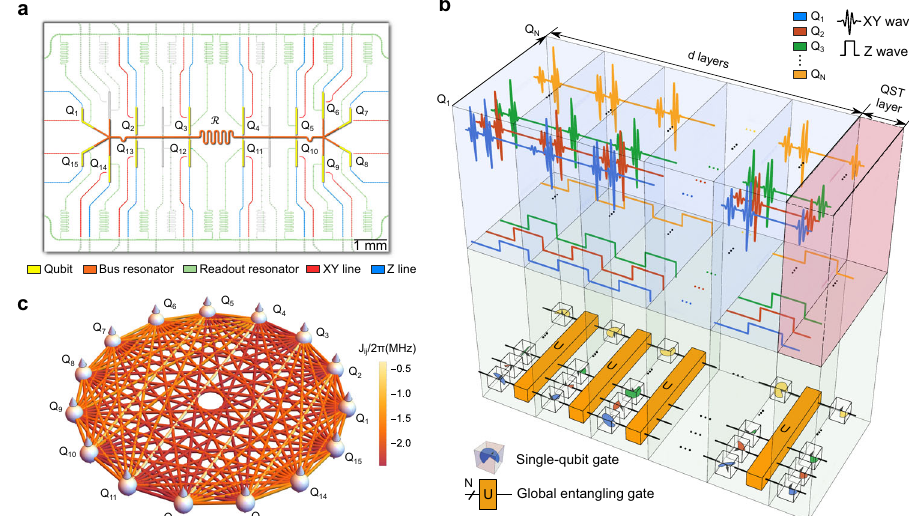
Fig. 1 | Quantum simulator and experimental pulse sequences. a False-color optical micrograph with highlighting various circuit elements. Qubits (yellow) are labeled from Q 1 to Q 15 and the central resonator (red) capacitively coupled to all qubitsislabeledas R .EachlabeledqubitcanbecontrolledbyitsXYline(red)andZ line (blue), and measured through the readout resonator (green). The device used